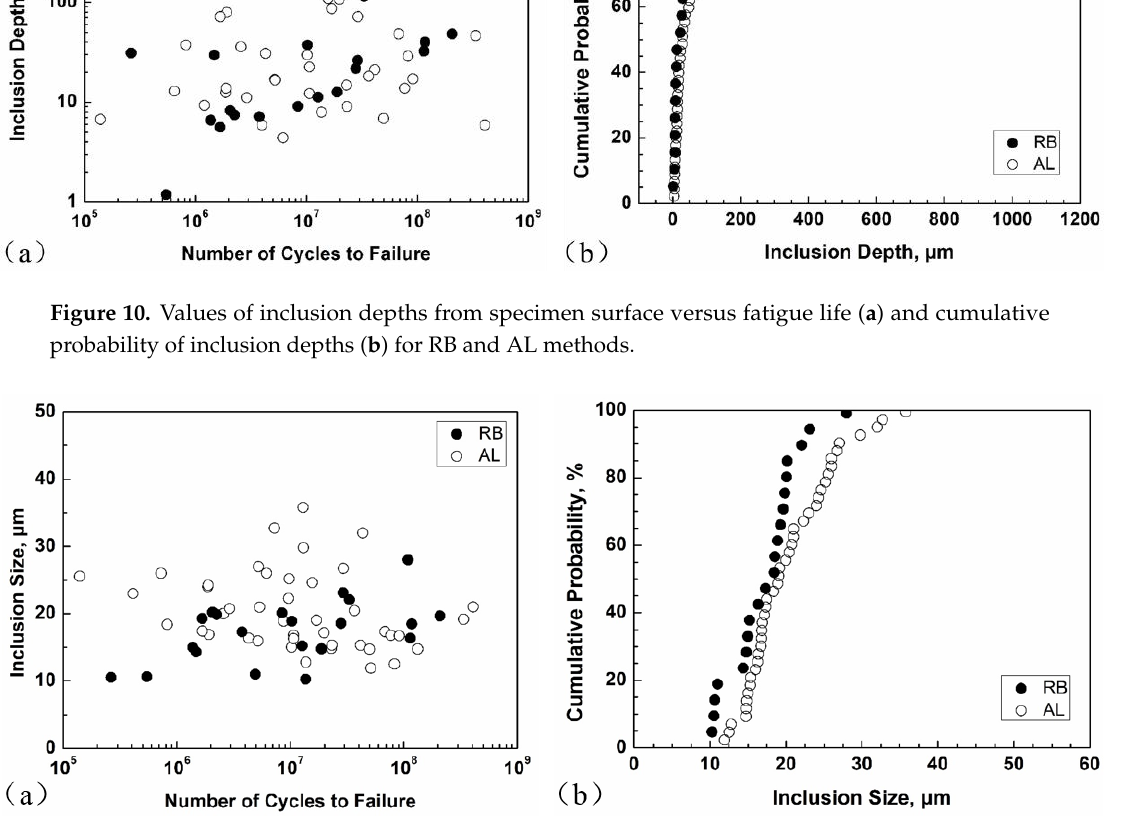
Figure 11. Values of inclusion sizes versus fatigue life ( a ) and cumulative probability of inclusion sizes ( b ) for RB and AL methods.